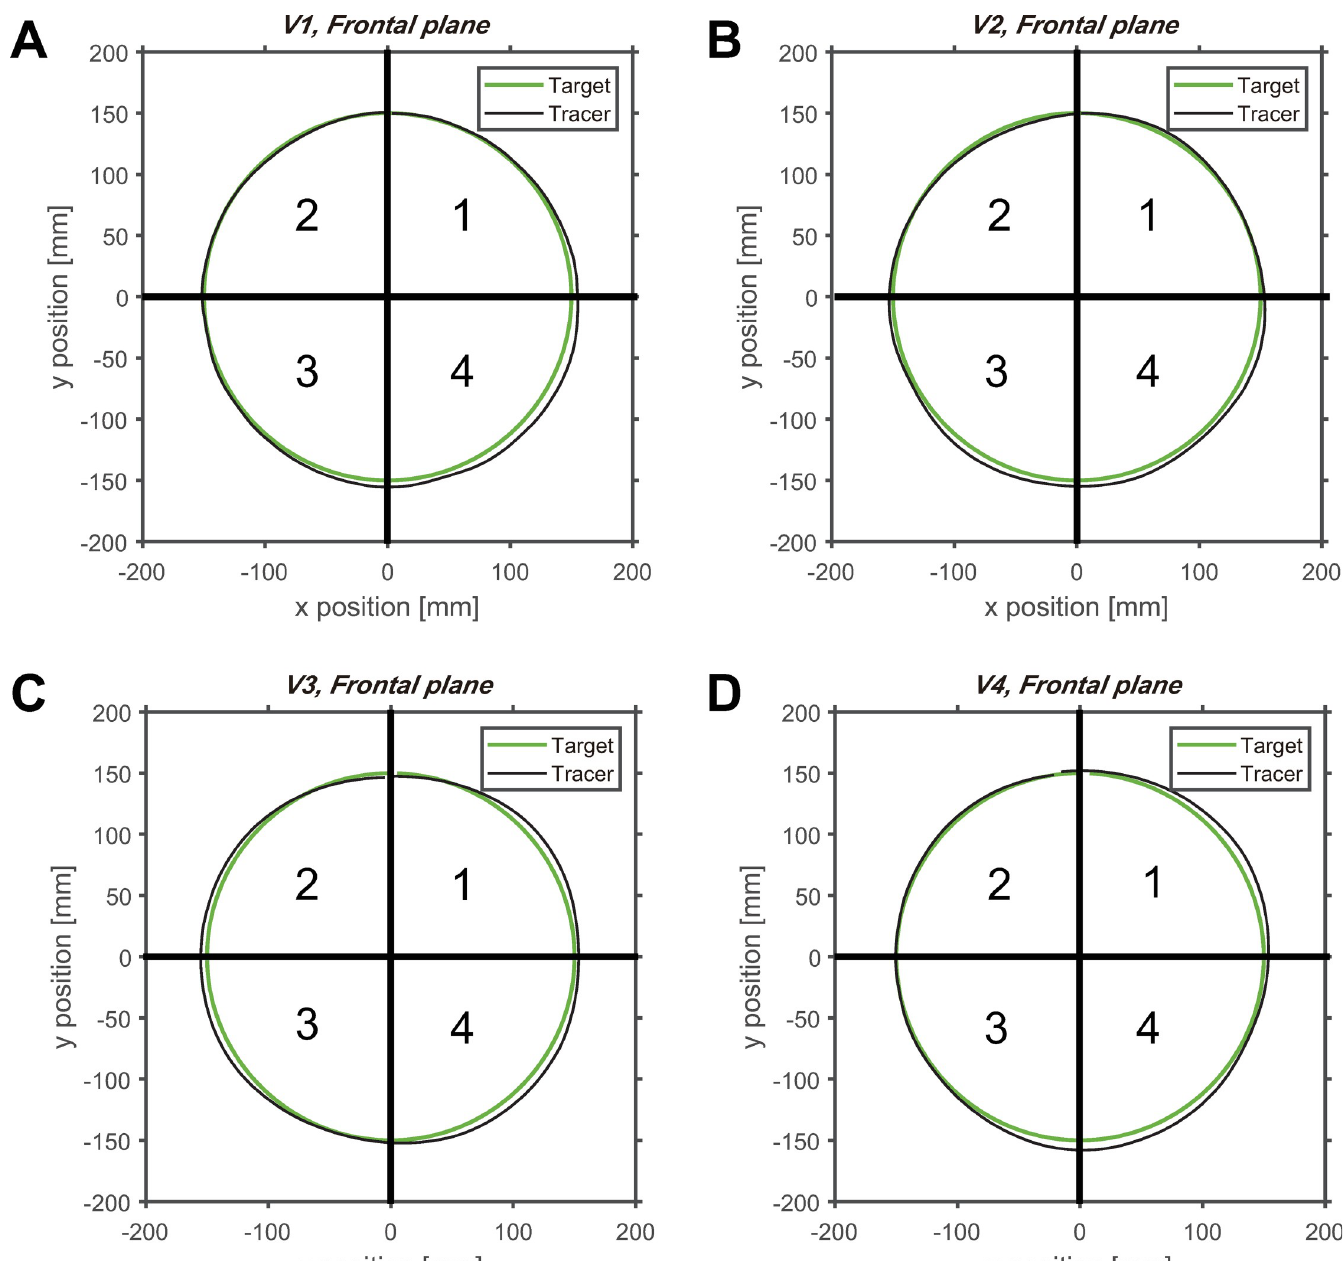
Fig 3. Average circular tracking movement in the frontal plane. (A) The movement trajectory of the target and controller at (A) V1 (0.125 Hz), (B) V2 (0.25 Hz), (C) V3 (0.5 Hz), and (D) V4 (0.75 Hz). The order of the moving target is the Q1 , Q4 , Q3 , and Q2 .